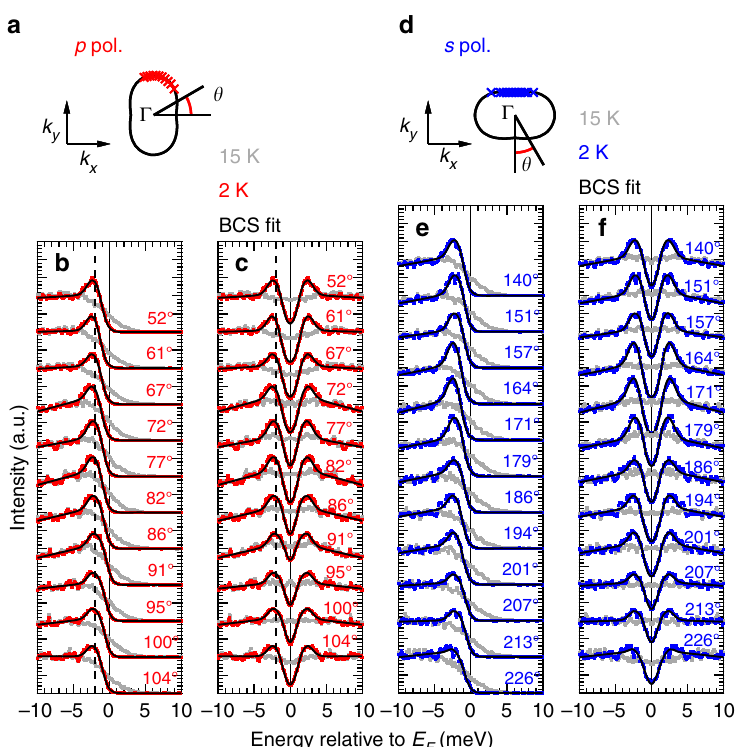
Fig. 2 Superconducting gap anisotropy of twinned FeSe. a De fi nition of FS angle in case of p -polarized light. Red points indicate the k F positions where energy distribution curves (EDCs) in b and c are taken. b EDCs at various k F points along the FS at 15 K (gray) and 2 K (red). Black lines show the fi ts to the BCS fi tting function. FS angle de fi ned in a is shown for each EDC. c The same as b but symmetrized with respect to E F . d – f The same as a – c but taken with